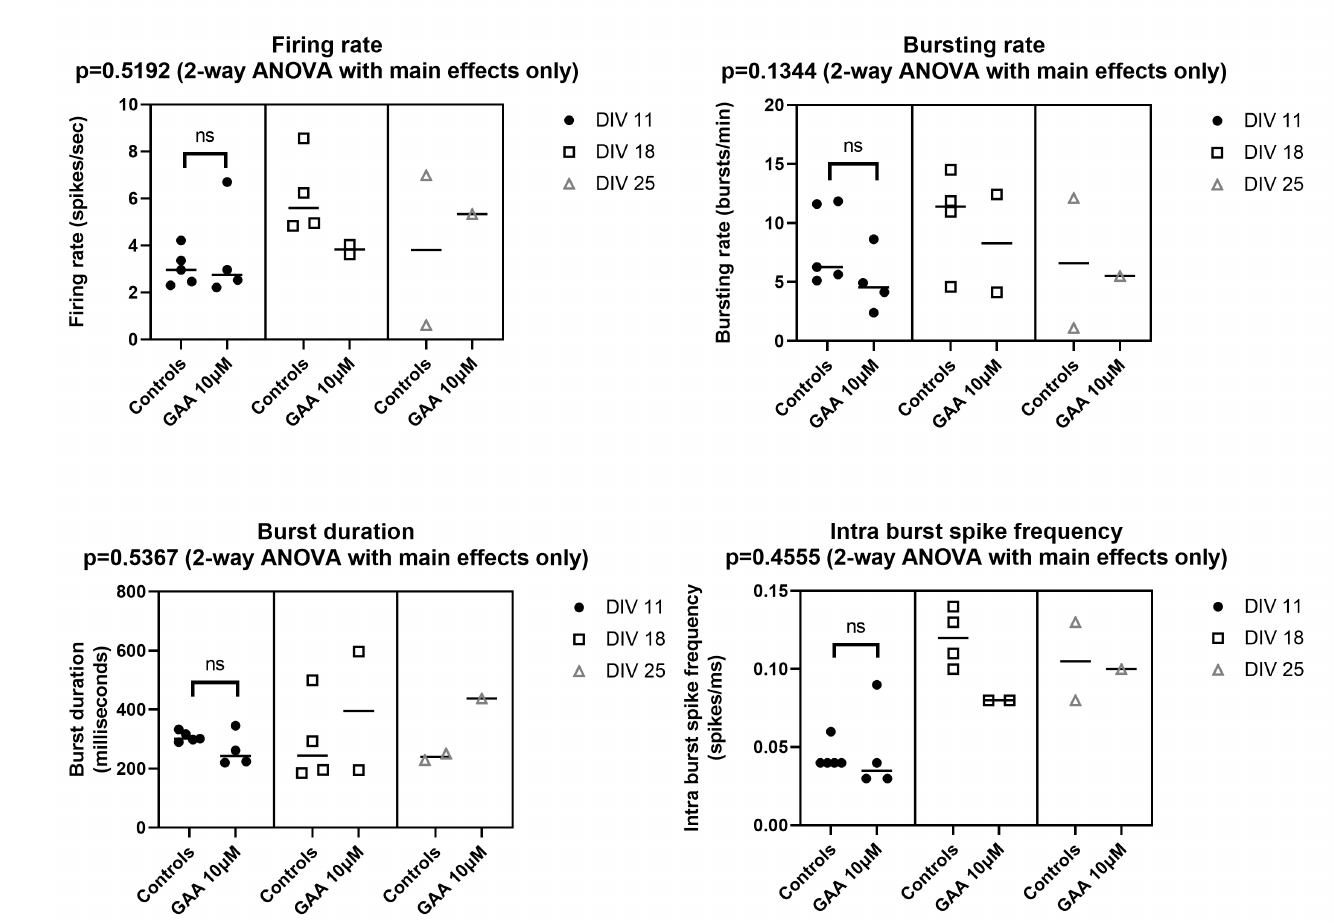
Figure 5. Effects of 10 µM Guanidinoacetic Acid (GAA) on the spiking and bursting parameters in neocortical networks. All parameters refer to spontaneous—not stimulus-evoked—activity. Sym- bols represent individual experiments. Horizontal bars represent medians. ns—not significant (Mann–Whitney test). See text for additional explanations.